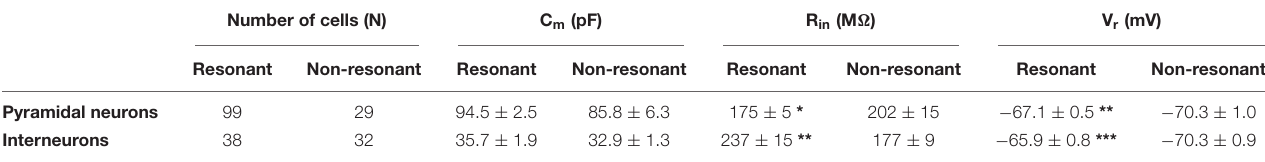
TABLE 4 | Comparison of the principal passive electrophysiological properties of resonant vs. non-resonant neurons of the PRC. Number of cells (N) C m (pF) R in (M (cid:127) ) V r (mV)